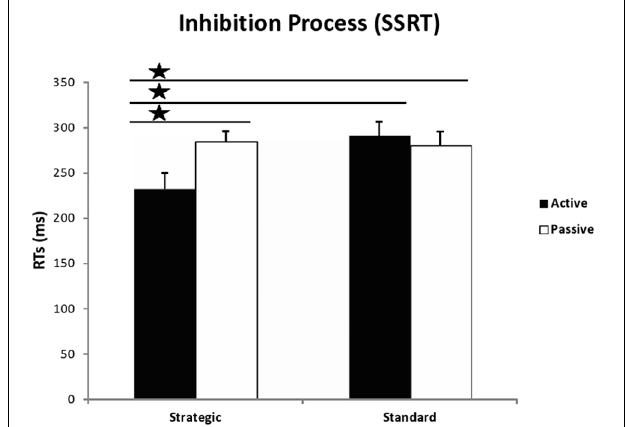
FIGURE 2 | Go RTs in milliseconds for active and passive participants in both conditions of the Stop Signal Task: strategic and standard. The star indicates significance (instruction effect) with p < 0 . 05.